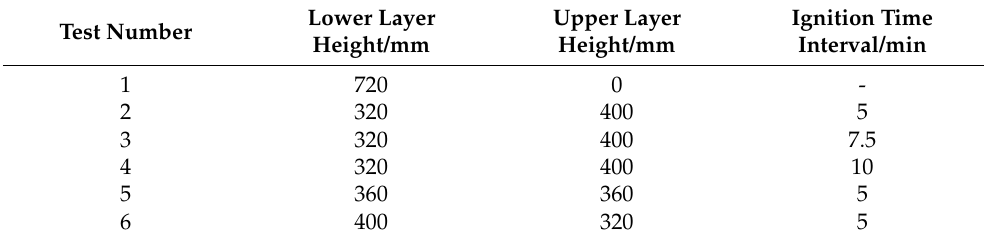
Figure 3. Schematic diagram of double-layer ignition sintering experiment device. Table 4. Experimental conditions.